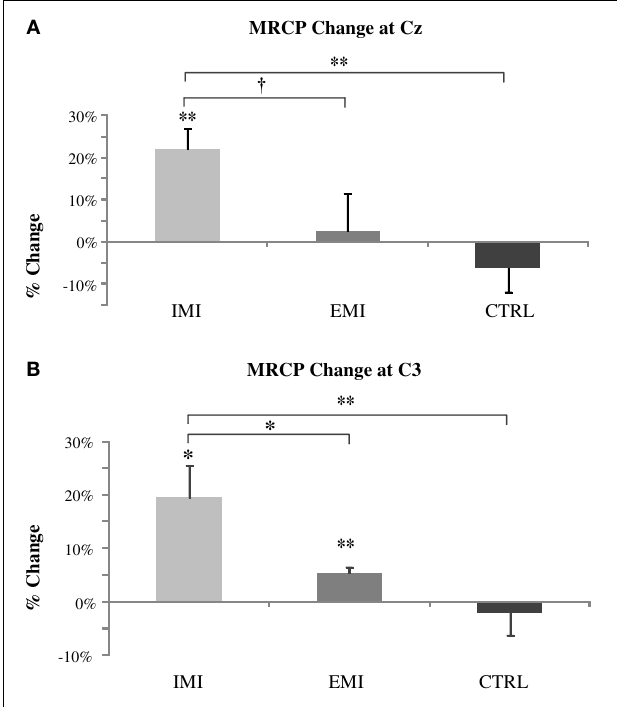
FIGURE 3 | Pre- to post-training percentage change in MRCP amplitude at Cz (roughly over the supplementary motor area) (A) and C3 (roughly over the contralateral sensory motor area) (B) locations. The IMI group had a significant increase in the MRCP amplitude at Cz and C3 and EMI at C3 only while no significant change was observed for CTRL groups did not. MRCP increases for IMI were significantly greater than control for Cz and C3 and greater than EMI for C3 and marginally so for Cz. EMI increases compared to Control were not significant. † P < 0 . 1, ∗ P < 0 . 05, ∗∗ P < 0 .